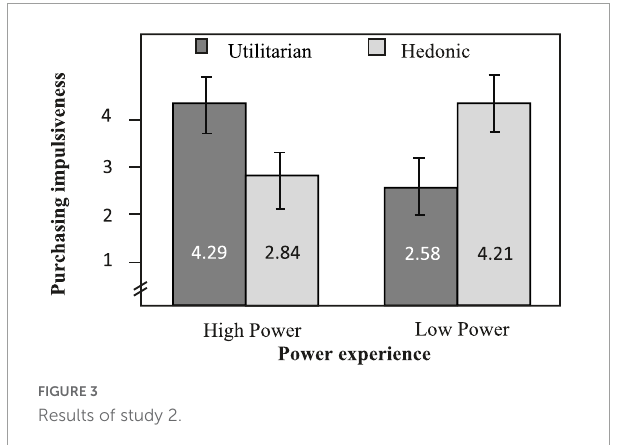
FIGURE3 Results of study